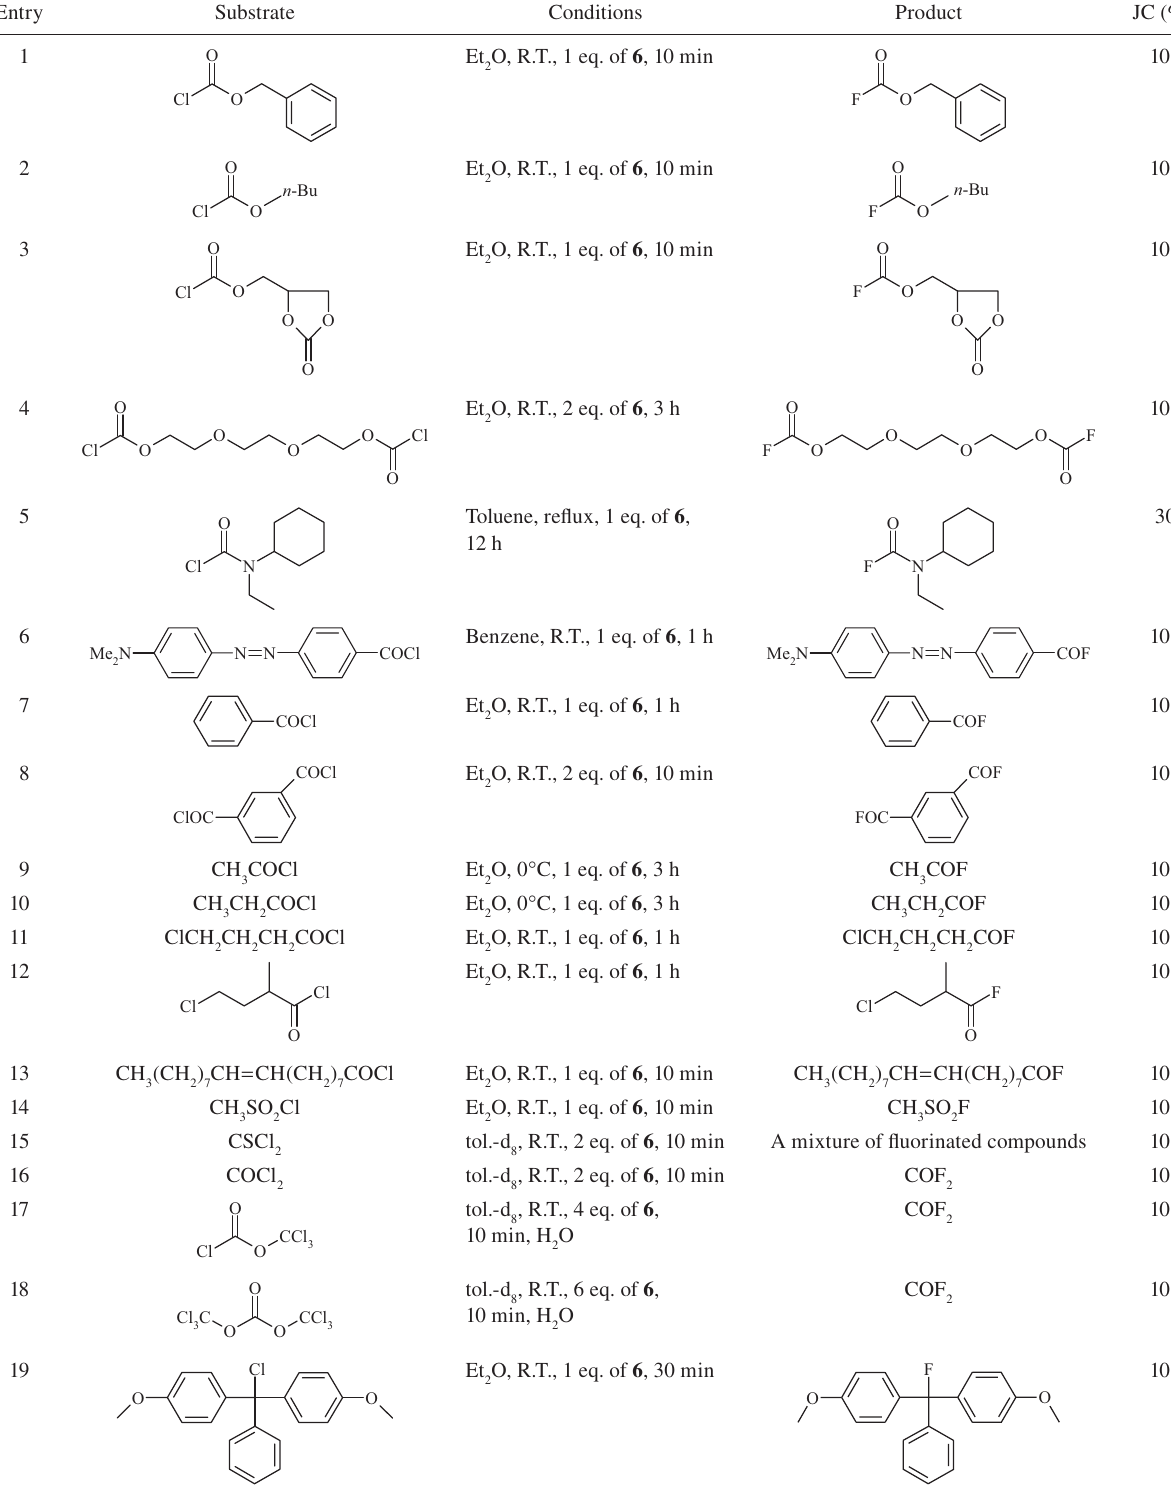
Table 5 Preparation of fl uoroformates, acyl fl uorides and fl uorophosgene. Entry Substrate Conditions